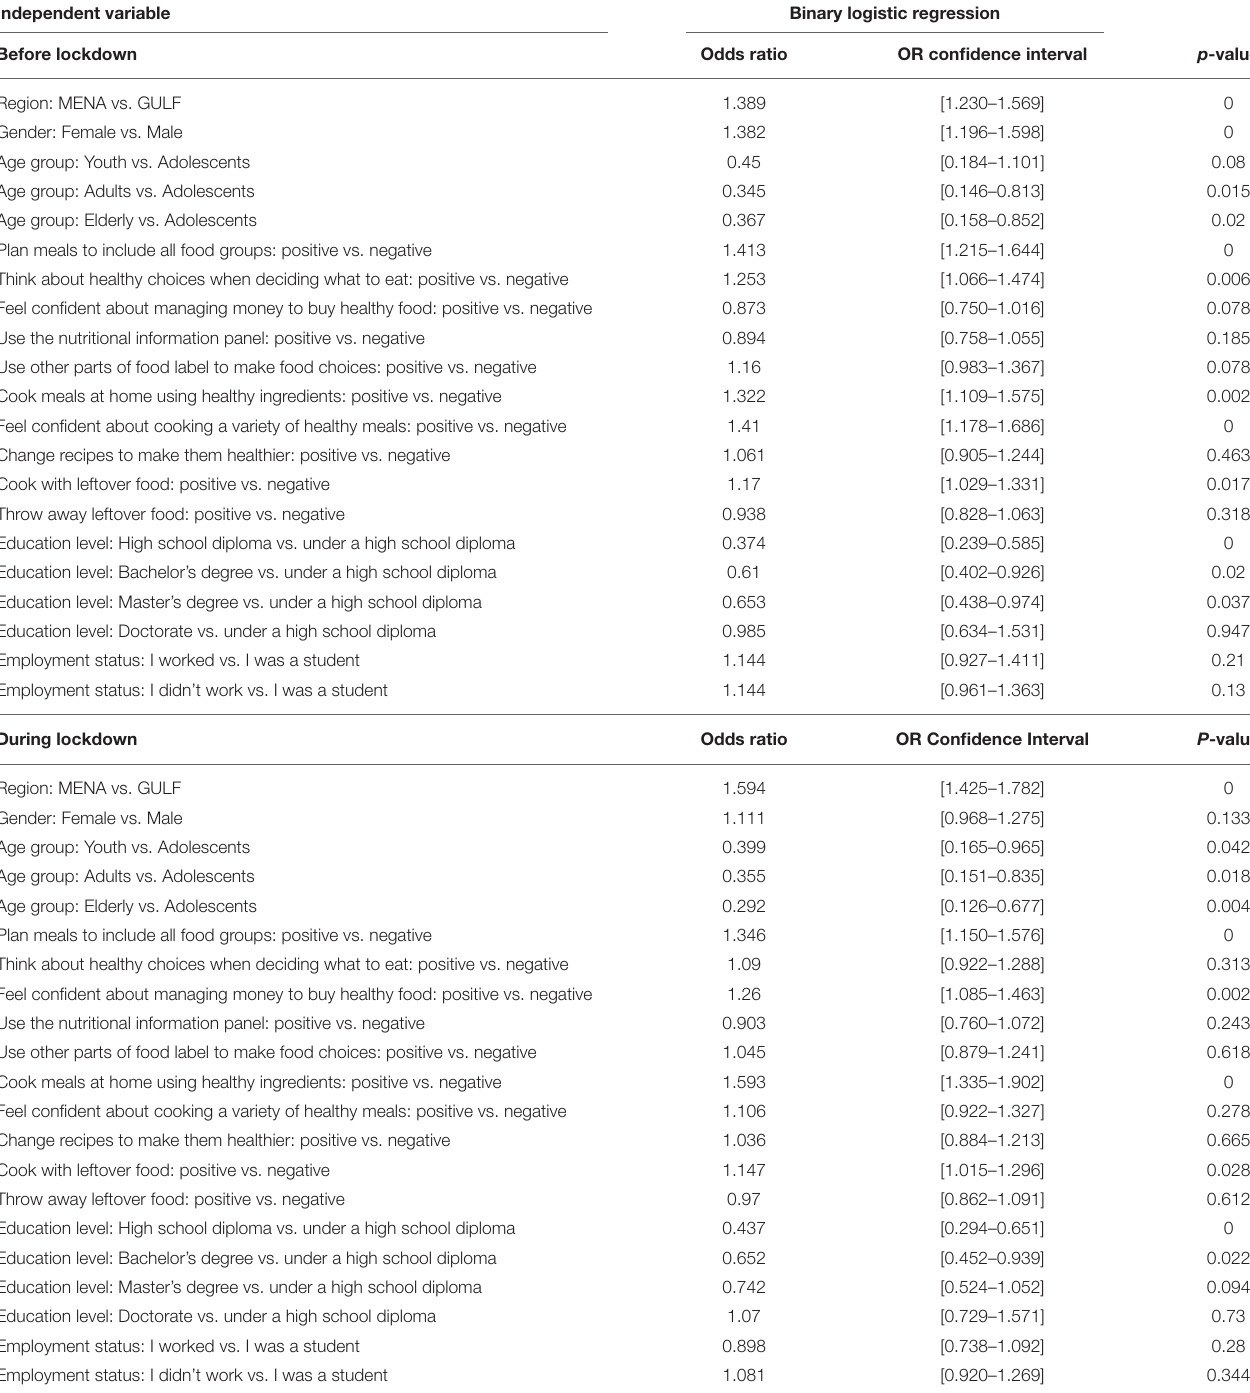
TABLE 6 | Backwards Odds ratios (OR) according to food consumption score. Independent variable Binary logistic regression Before lockdown Odds ratio OR confidence interval p